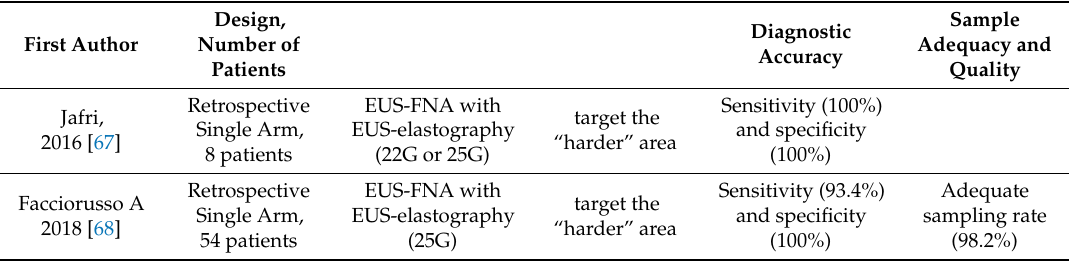
Table 2. Targeting EUS-FNA with EUS-elastography for pancreatic solid